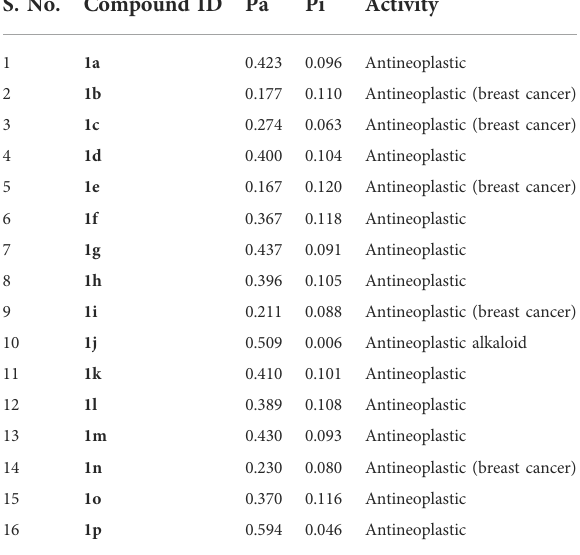
Figure 11, it is observed that all the fi ve domains such as 1 )